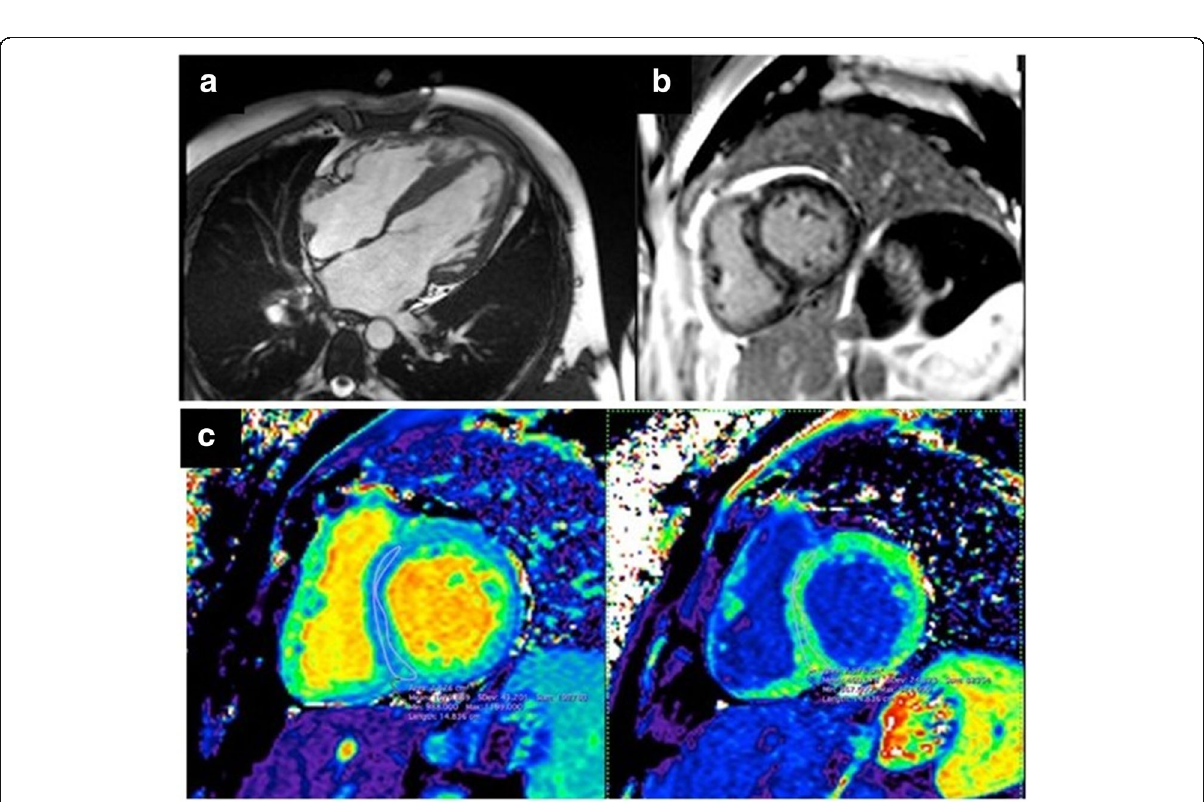
Fig. 3 Cardiac MRI. a . Biventricular hypertrophy with maximal wall thickness of 19 mm at inferoseptal level; b . Late gadolinium enhancement basal mid-myocardial disposition. C. Diffuse high T1 values (1074 ms precontrast administration) with extracellular volume expansion to